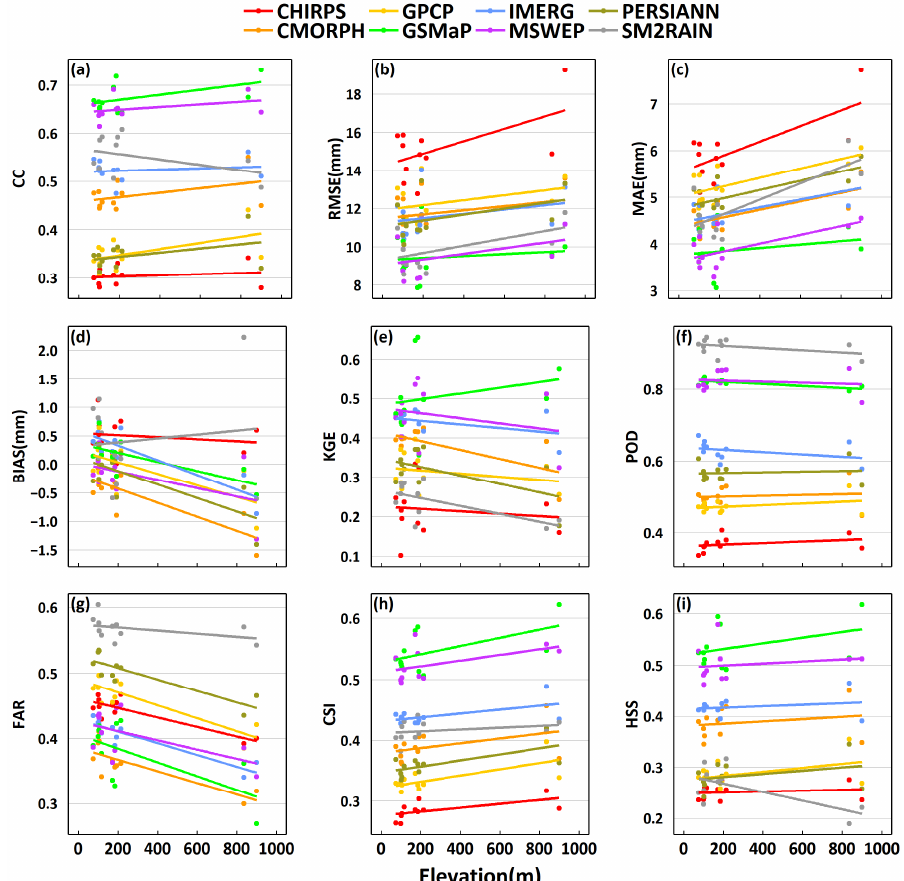
Figure 6. Relations between statistical metrics and elevation for CHIRPS, CMORPH, GPCP, GSMaP, IMERG, MSWEP, PERSIANN, and SM2RAIN at a gauge grid scale: ( a ) correlation coefficient (CC), ( b ) RMSE, ( c ) MAE, ( d ) BIAS, ( e ) KGE, ( f ) POD, ( g ) FAR, ( h ) CSI, and ( i ) HSS. The coloured lines depict the linear trends.